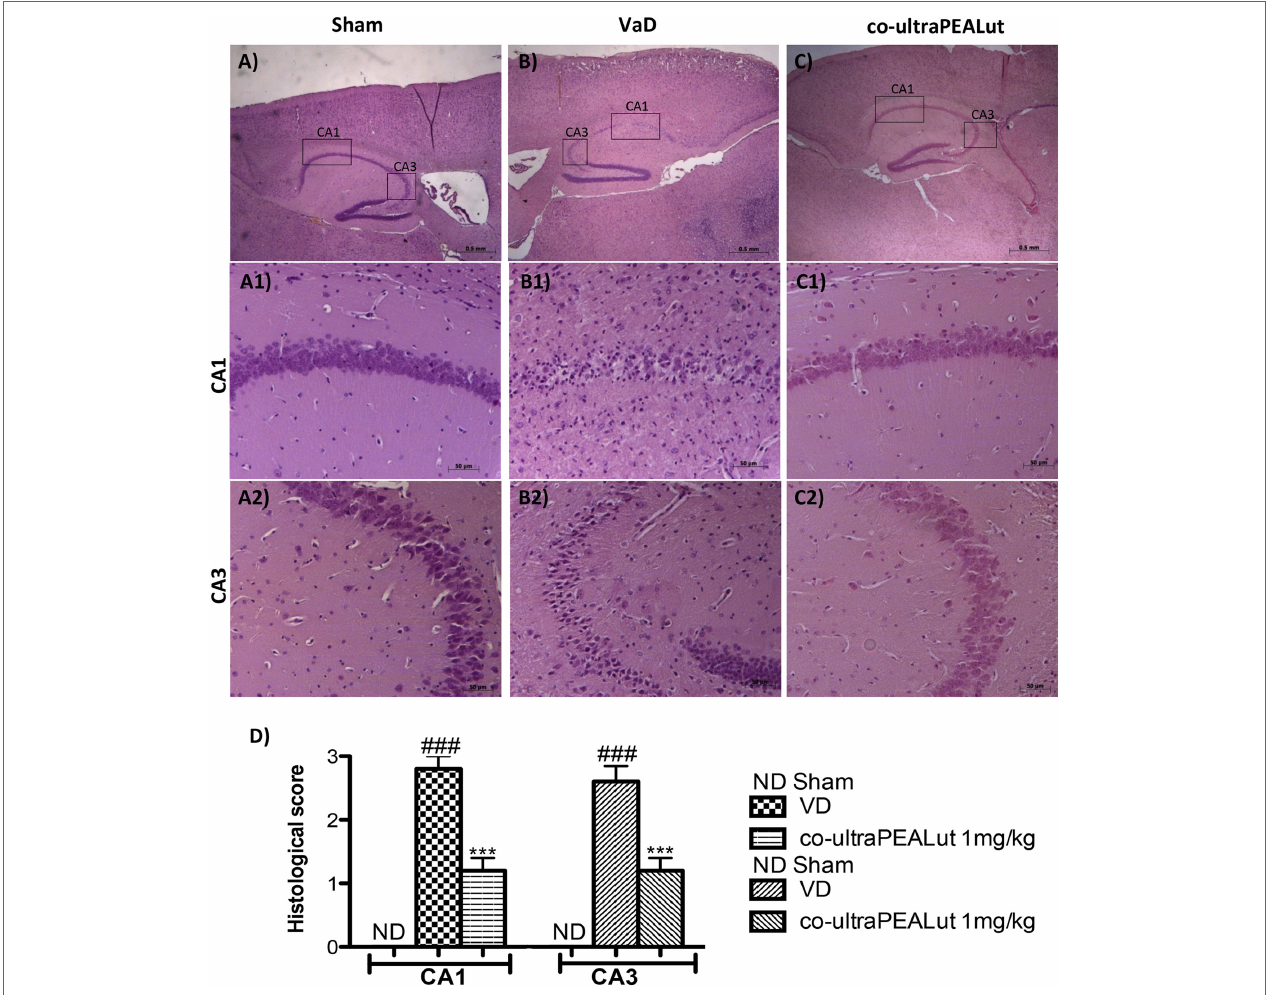
FigUre 2 | effects of co-ultraPealut on histological parameters in hippocampal area after carotid arteries occlusion . Control mice showed large numbers of nerve cells with closely arranged, neat and rounded nuclei in hippocampal (a) , in particular in CA1 and CA3 regions (a1,a2) , whereas vascular dementia (VaD) mice showed low number of nerve cells and hippocampal disorganized structure (B,B1,B2) . Co-ultraPEALut treatment restored the number of neurons to a level comparable to control mice (c) and mice showed a reorganization of hippocampal CA1 and CA3 regions (c1,c2) . These data are also visible in the histological score (D) . *** p < 0.001 vs. Sham; ### p < 0.001 vs. VaD, as determined by one-way ANOVA followed by Bonferroni post hoc